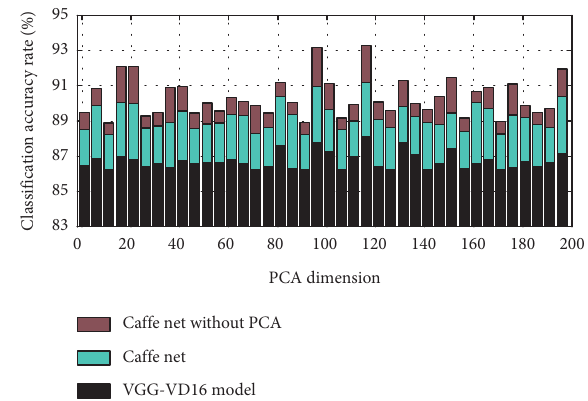
Figure 6: The influence of the Hellinger kernel on the “middle feature level